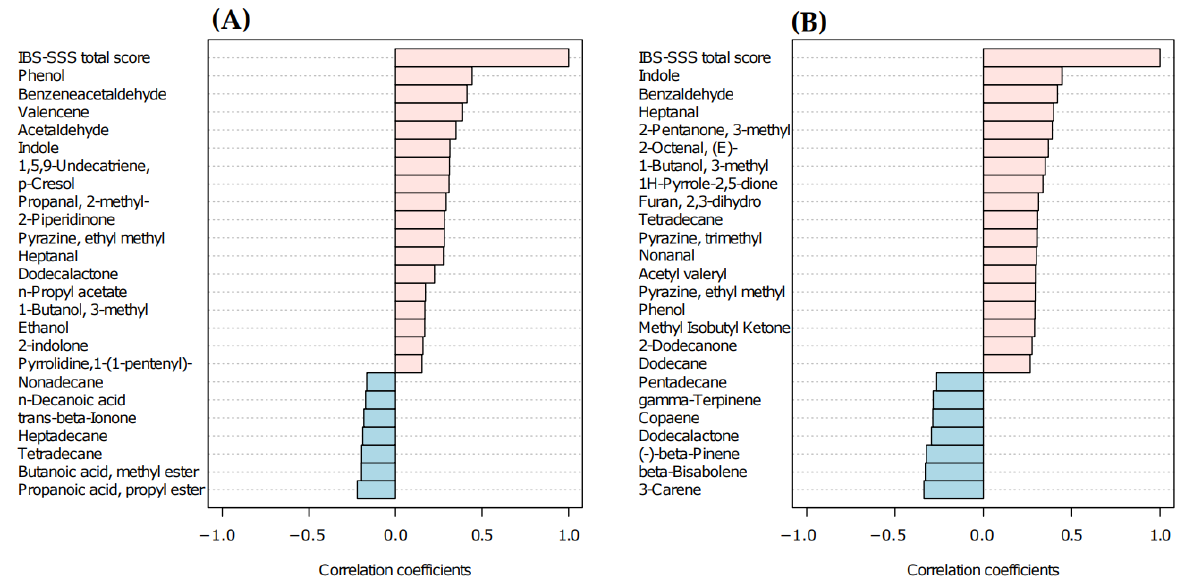
Figure 4. Spearman R-correlation coefficient of top 25 VOCs with IBS-SSS total score in patients administered with TBD ( A ) and LFD ( B ). Positive correlation values are shown in pink, while negative ones are in light blue. Abbreviations: LFD, low-FODMAPs diet; TBD, tritordeum-based diet; VOC, volatile organic